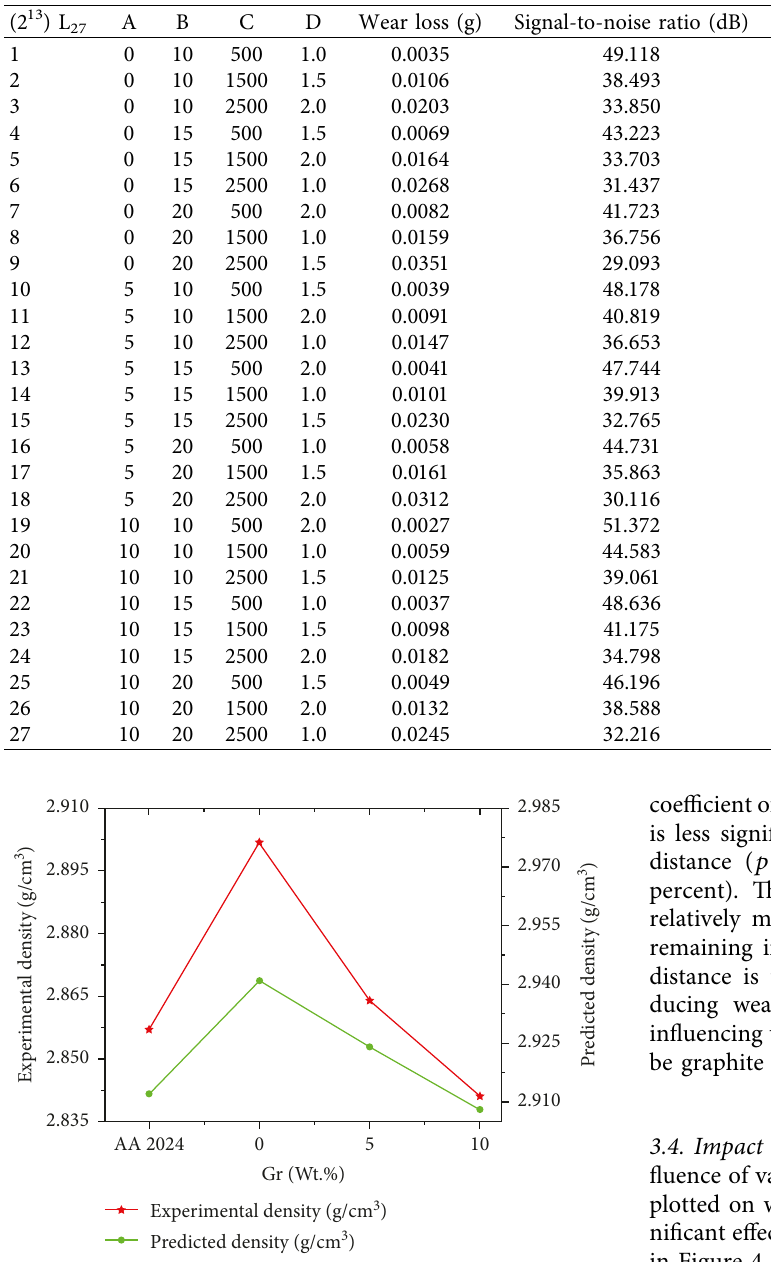
Table 5: Experimental design using L